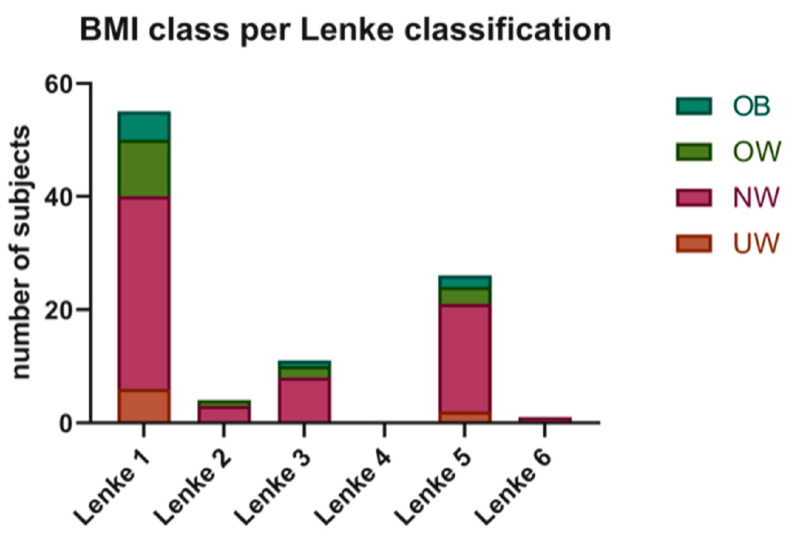
Figure 4. BMI classes (UW, BMI% ≤ 5; NW, 5 < BMI% ≤ 84; OW, 84 < BMI% < 95; OB, BMI% ≥ 95) per Lenke classification.